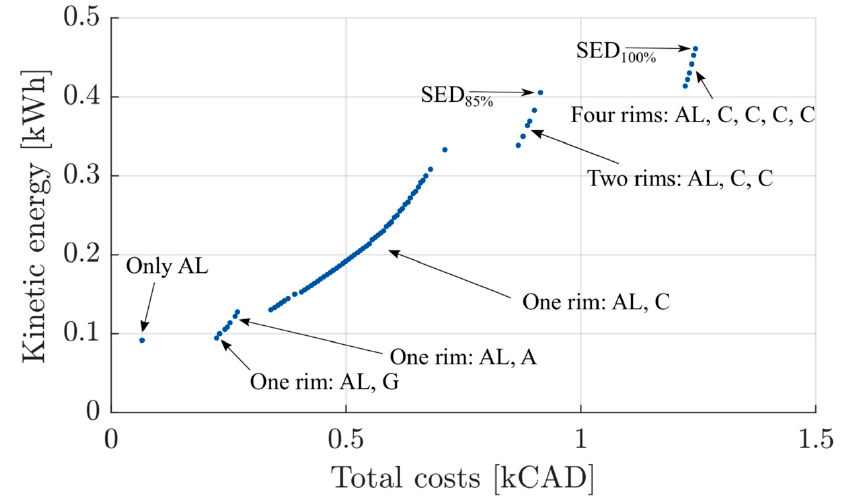
Figure 4. Two ‐ dimensional Pareto ‐ front of the ACME geometry, AL: aluminum, A: aramid, G: glass, C: carbon.